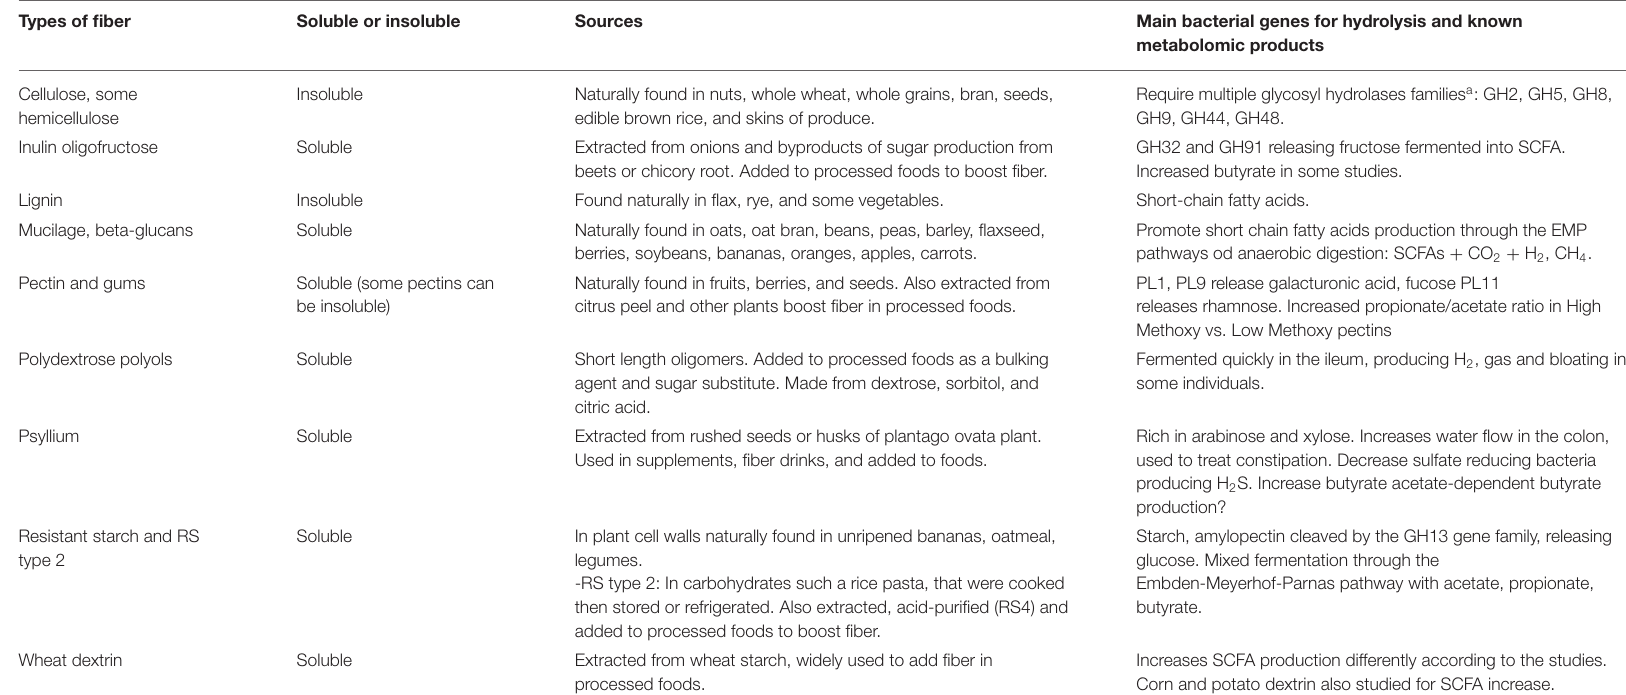
TABLE 2 | The different types of dietary fiber [modified from